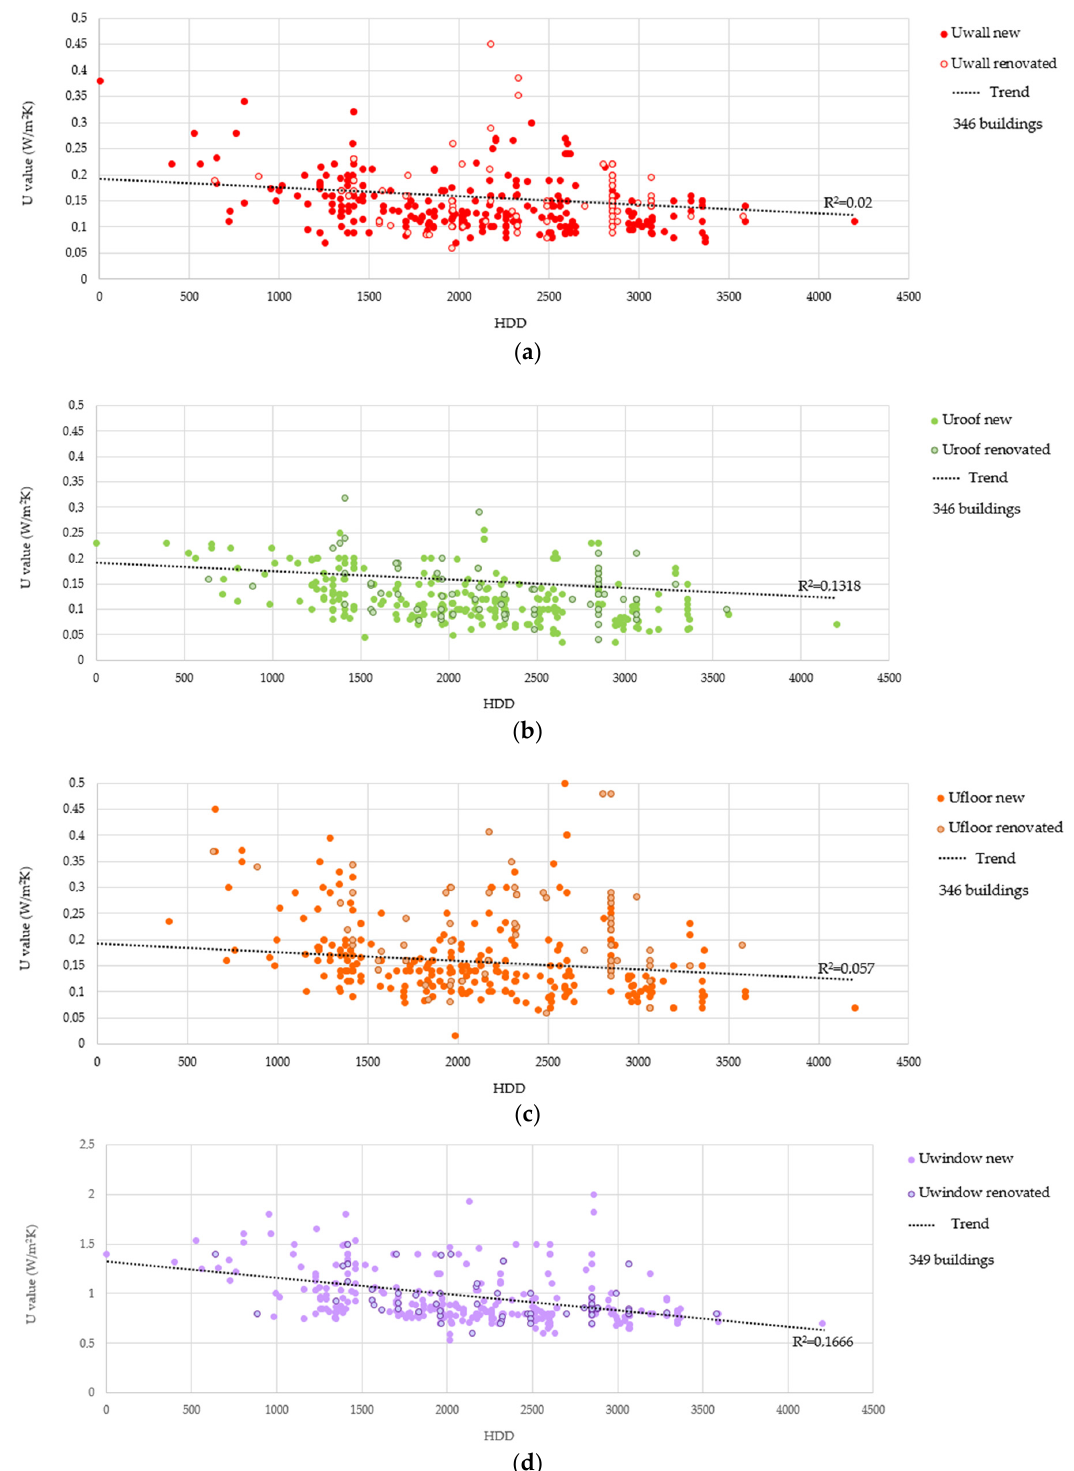
Figure 7. Thermal transmittances of walls ( a ); roofs ( b ); ground floors ( c ) and windows ( d ) of nZEB in relation of the use of the buildings (residential and non ‐ residential) according to HDD.